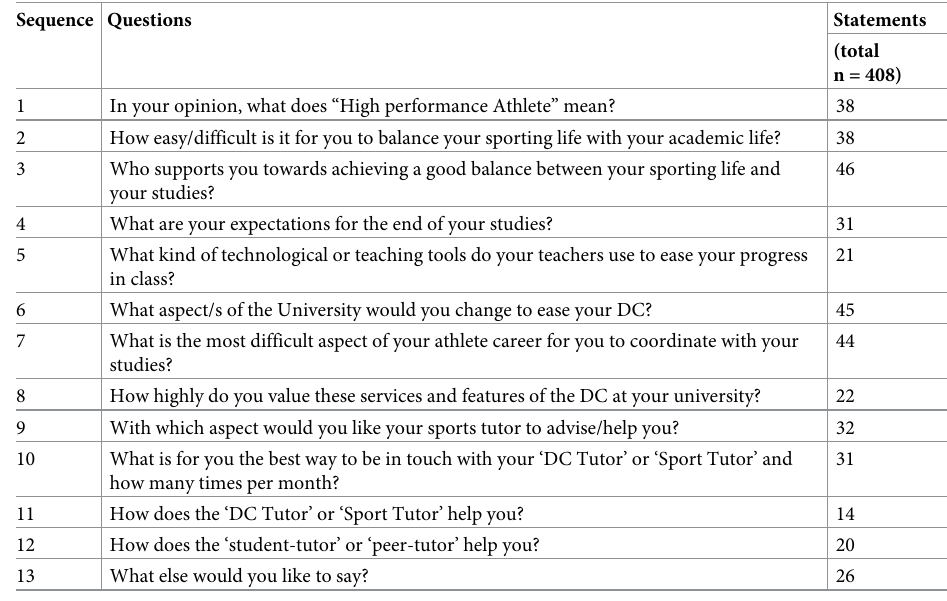
Table 1. Sequence of thirteen questions addressed during the national focus groups and overall outcome state- ments to guide the development and/or implementation of dual career (DC) academic support and services at Higher Educational Institutions